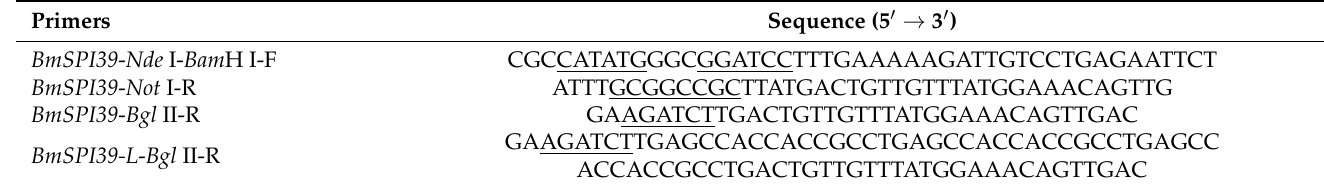
Table 1. Primers required for expression vector